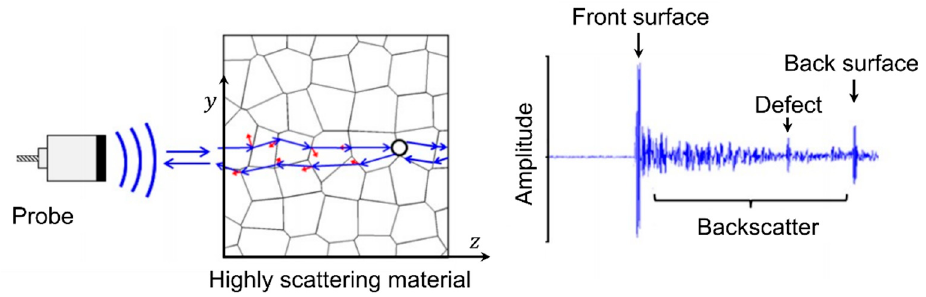
Figure 4. Conceptual diagram of pulse echo testing for attenuation measurement, modified from [31].